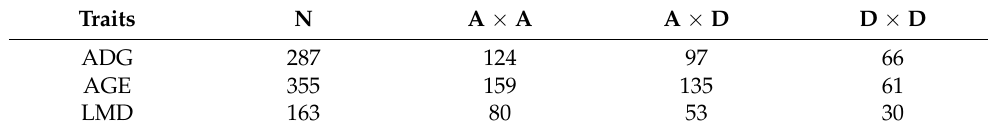
Table 4. Summary information of significant epistatic effects for growth traits. Traits N A × A A × D D × D ADG 287 124 97 AGE 355 159 61 LMD 163 80 53